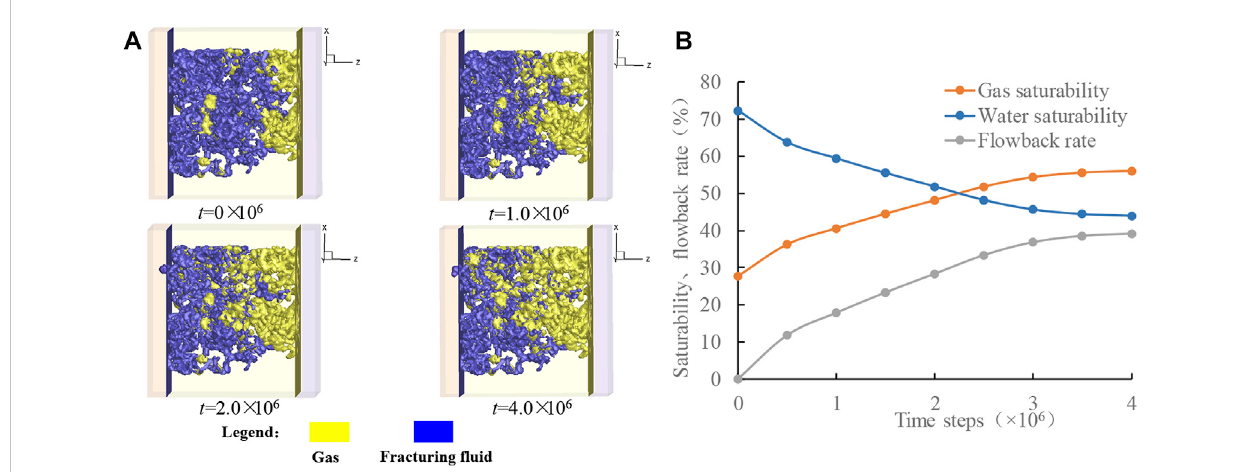
FIGURE 8 The gas-liquid distribution in shale at different time steps (A) and the water saturation, gas saturation, and fl owback rate versus time steps (B) in the fl owback process.